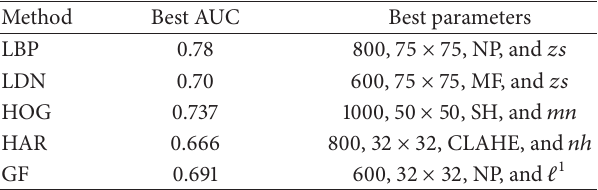
Table 8: Results of the ExS